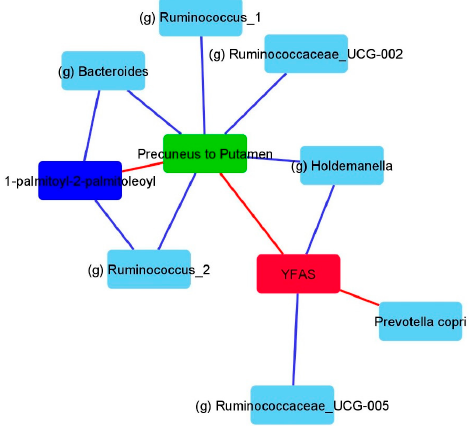
Figure 6. Summary figure depicting a subset of the associations across brain imaging, microbiome, metabolite, and eating behavior. This figure was solely created based on analysis, as previously mentioned above. Blue lines depict negative associations and red lines depict positive associations. YFAS: Yale Food Addiction Score.